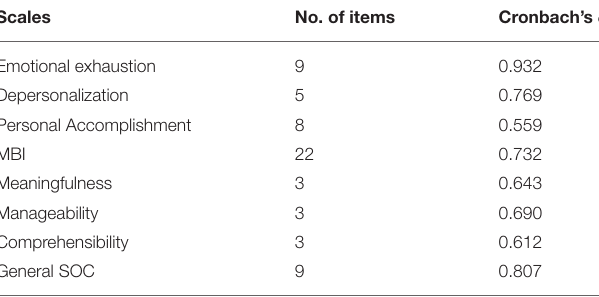
TABLE 2 | Internal consistency (Cronbach’s α ) of the SOC and MBI subscales.